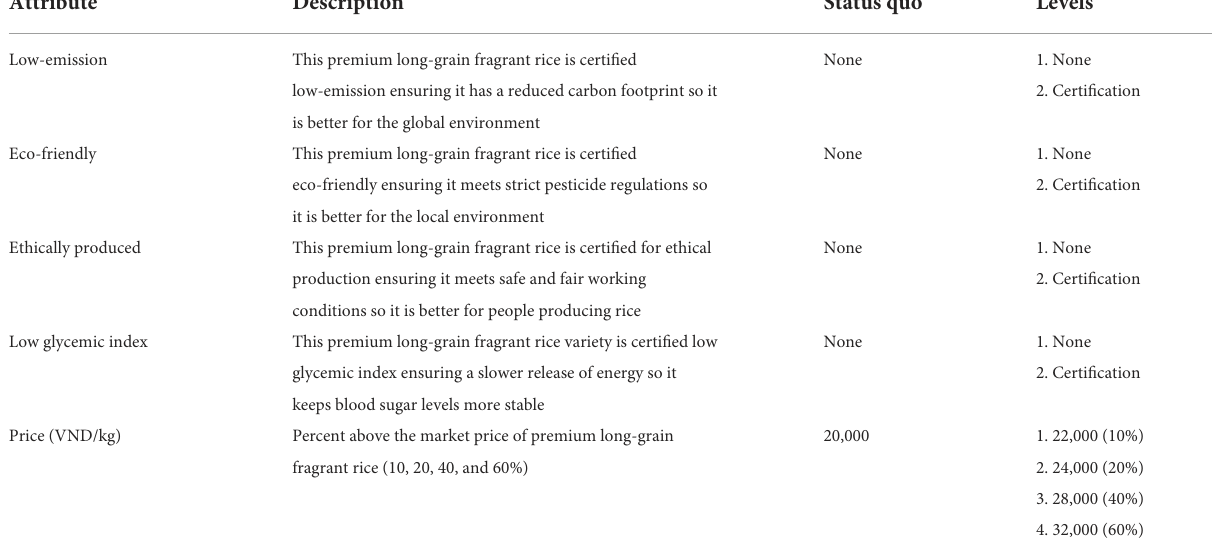
TABLE 1 Selected attributes and attribute levels.